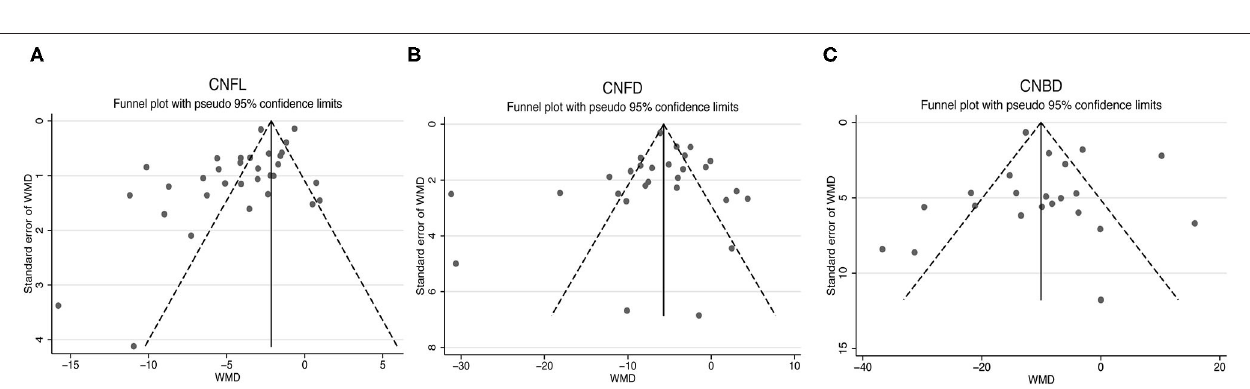
FIGURE 7 | Funnel plots for studies included reported CNFL (A) , CNFD (B), and CNBD (C) . CNFL, corneal nerve fiber length; CNFD, corneal nerve fiber density; CNBD, corneal nerve branch density; WMD, weighted mean